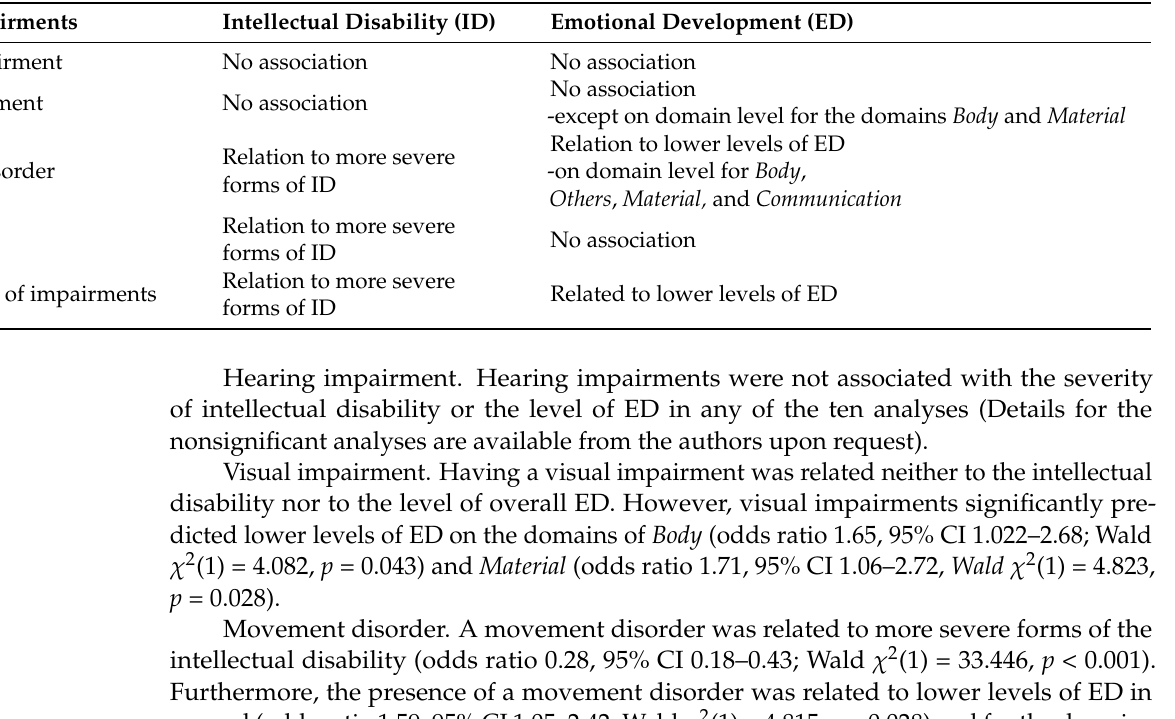
Table 3. The associations between sensory impairments, ID, and